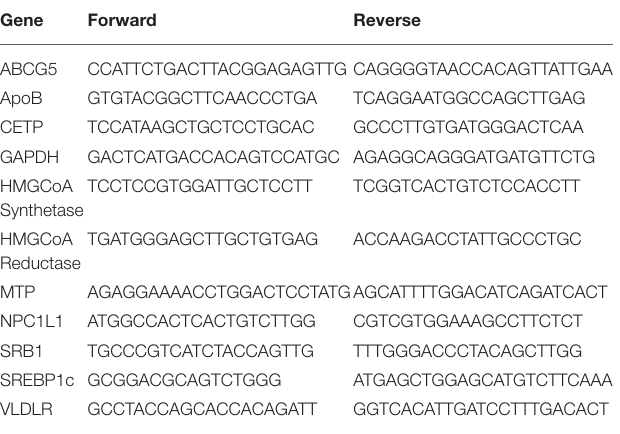
TABLE 1 | The primers used in real-time polymerase chain reaction (PCR).